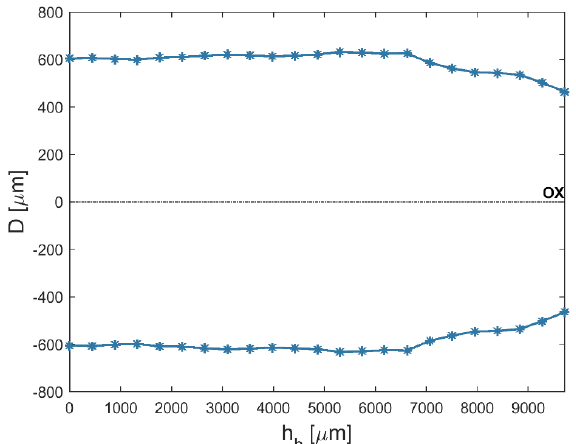
Figure 9. The profile of the drilled hole for the minimum value of applied pulse time t i = 100 μs, U = 100 V, I = 3.83 A, and tap α = 0.015.